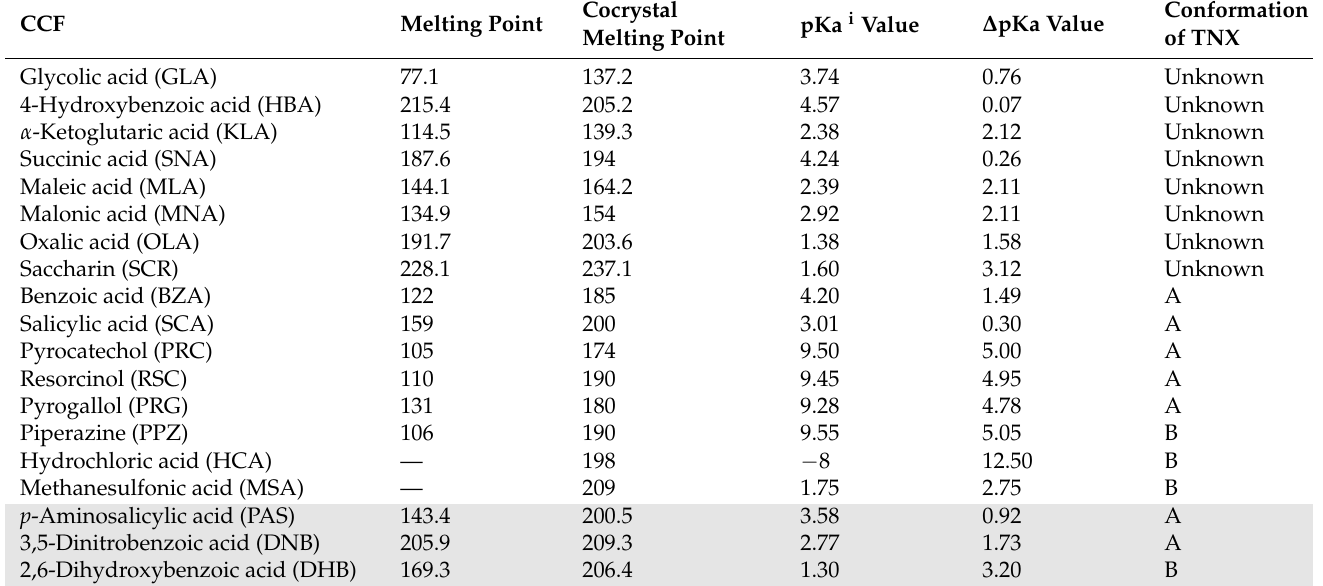
Table 1. The melting point, pKa, and ∆ pKa of different CCFs and TNX cocrystals.